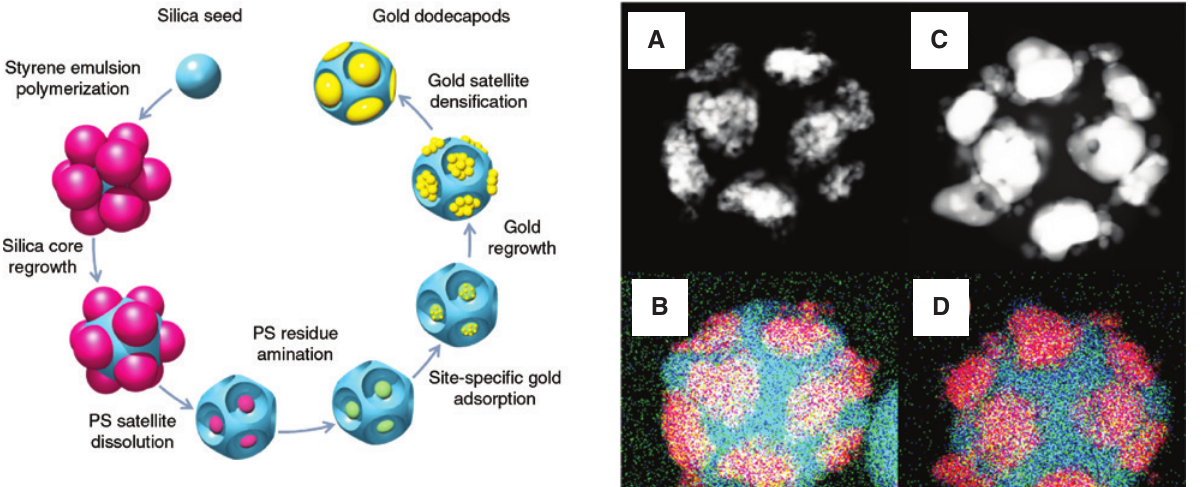
Figure 3: Schematic process for the synthesis of AuDDPs. The growth of the polystyrene nodules defines 12 geometrical sites that are subsequently functionalized to promote gold adsorption. The final structure is obtained after gold regrowth and thermal annealing. Figure 4: Synthesized dodecapods.